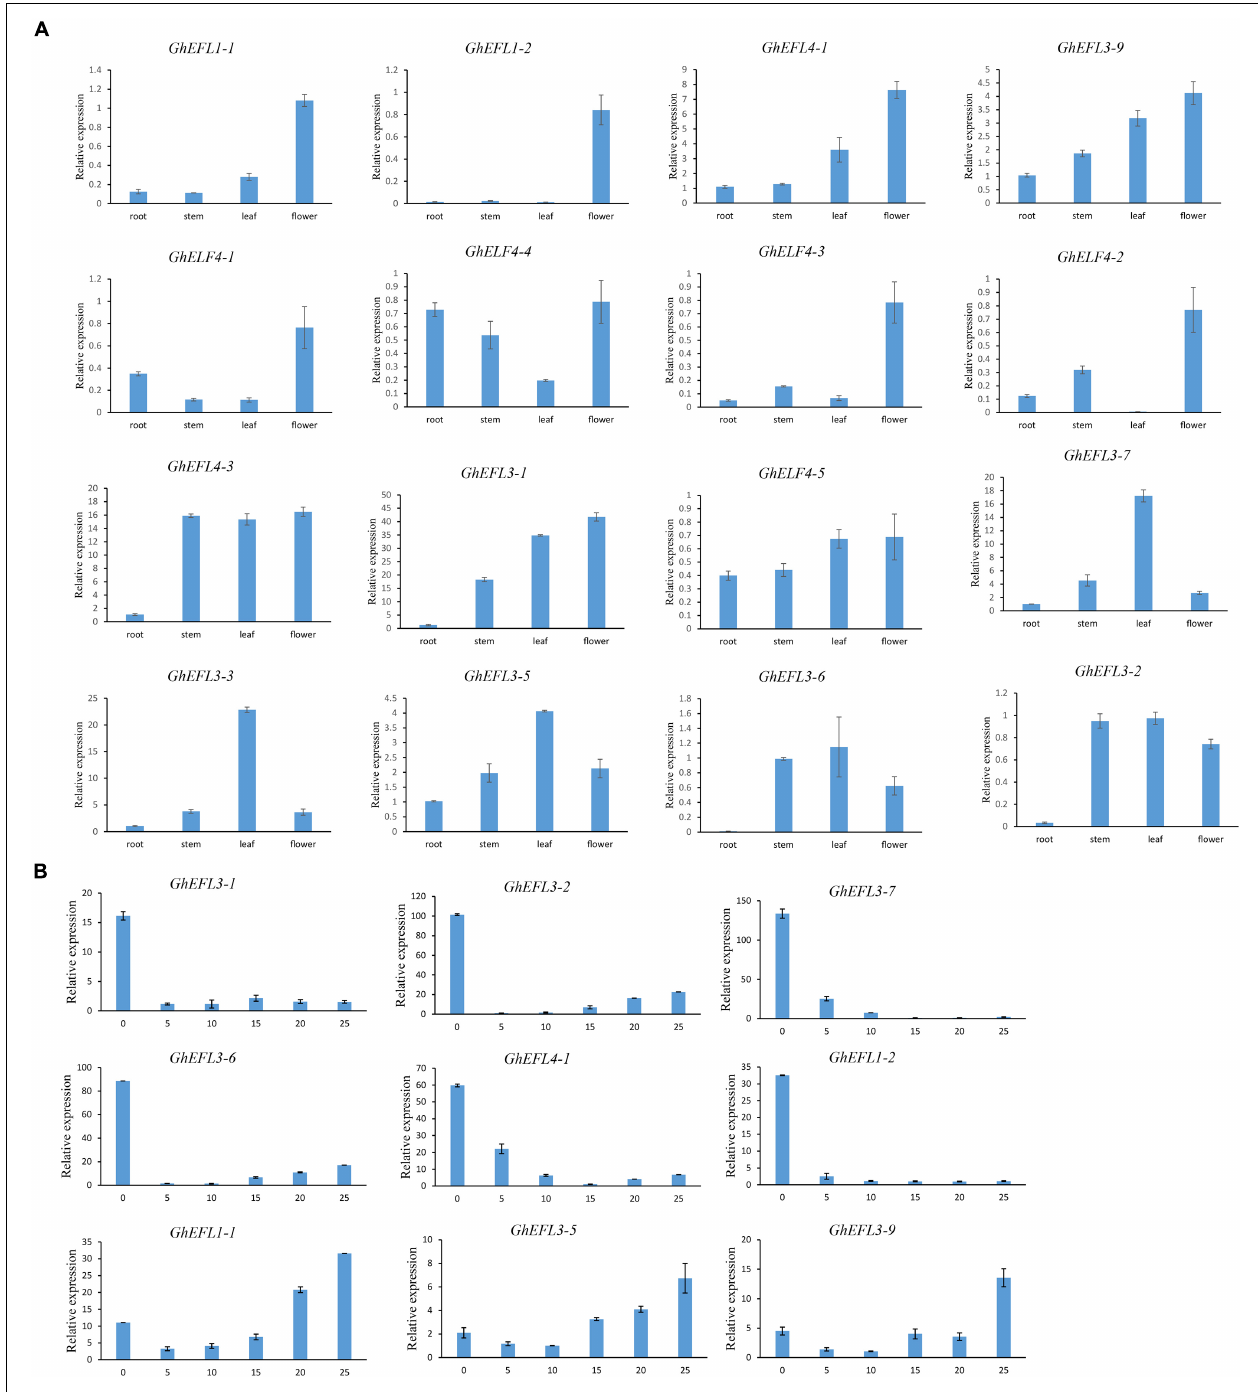
FIGURE 7 | Relative expression levels of GhELF4s in different tissues. (A) Expression analysis of GhELF4 in roots, stems, leaves and flowers. (B) Expression analysis of GhELF4s in fiber developmental stages. 0, 5, 10, 15, 20, and 25 represent 0, 5, 10, 15, 20, and 25 DPA fibers. Error bars showed the standard deviation of three biological